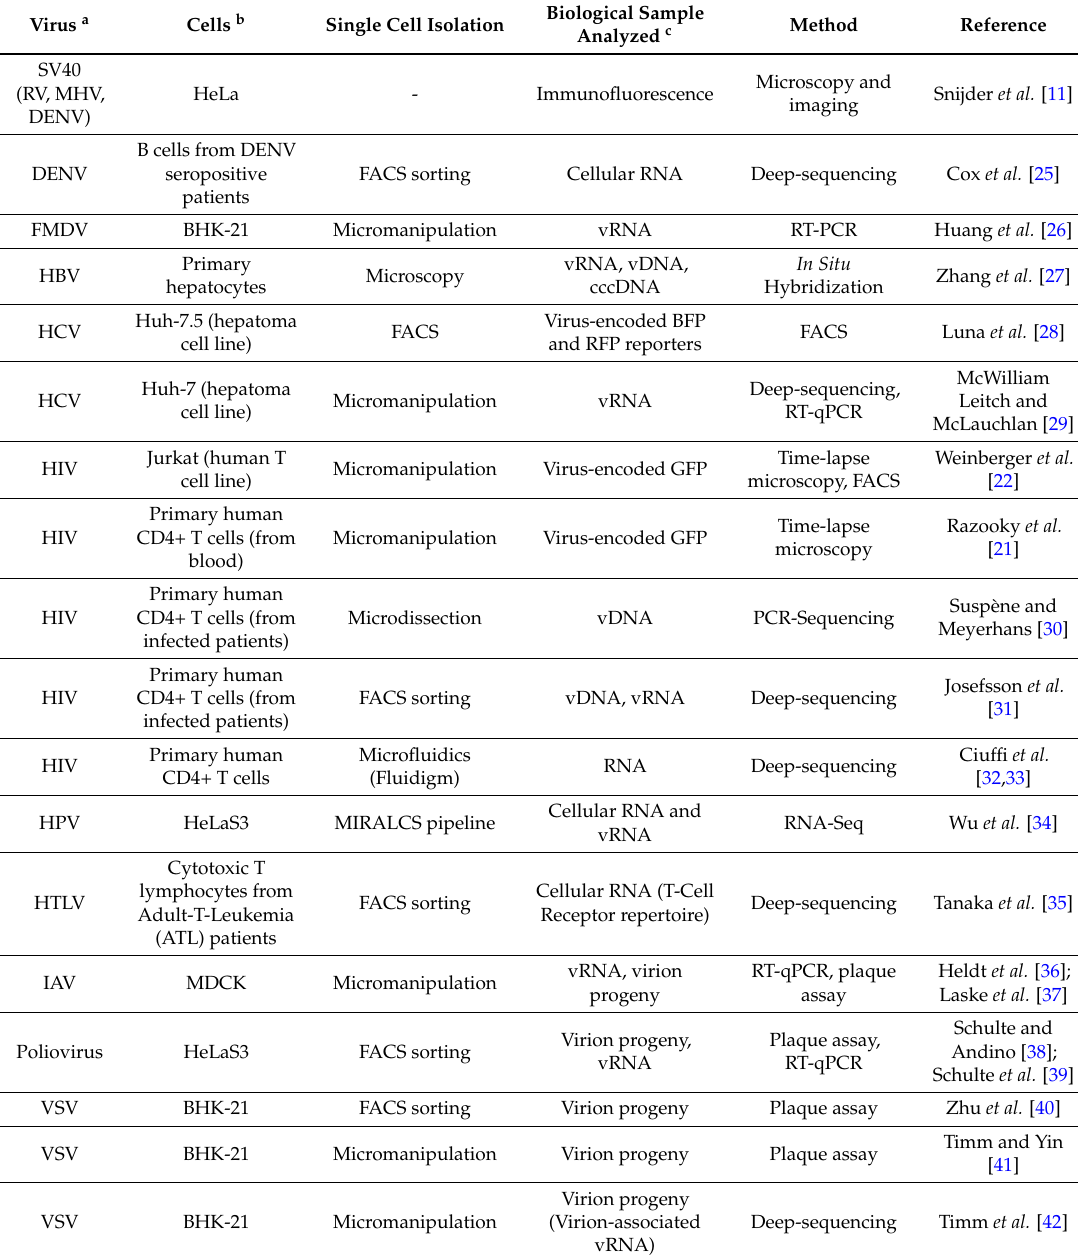
Table 1. Single cell analysis